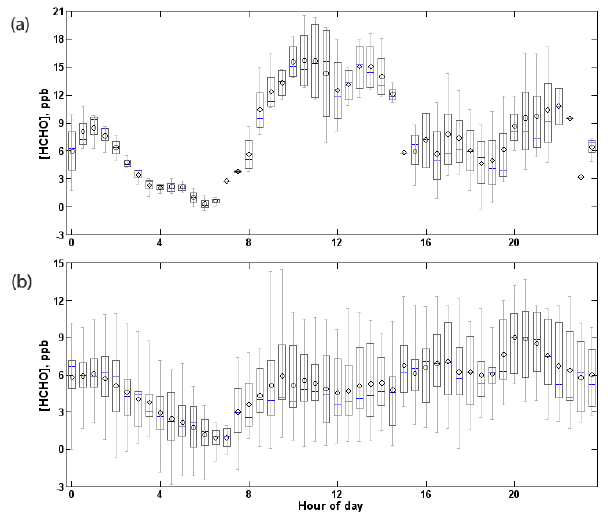
Fig. 5. Box plots of the average diurnal HCHO concentration pat- terns observed during BEARPEX 2007. The upper plot is for the High phase (days 259 ∼ 261 and 264) and the bottom plot is the Low phase (262 ∼ 263 and 265 ∼ 277) during which there were occa- sional rain and snowfall events. 50% of observed data is distributed within each 30min box and vertical bars denote maximum and min- imum. Black circles and blue horizontal bars represent mean and median, respectively. Average daytime (10:00 ∼ 16:00) [HCHO] = 7 . 3 ± 0 . 8ppb for the entire measurement